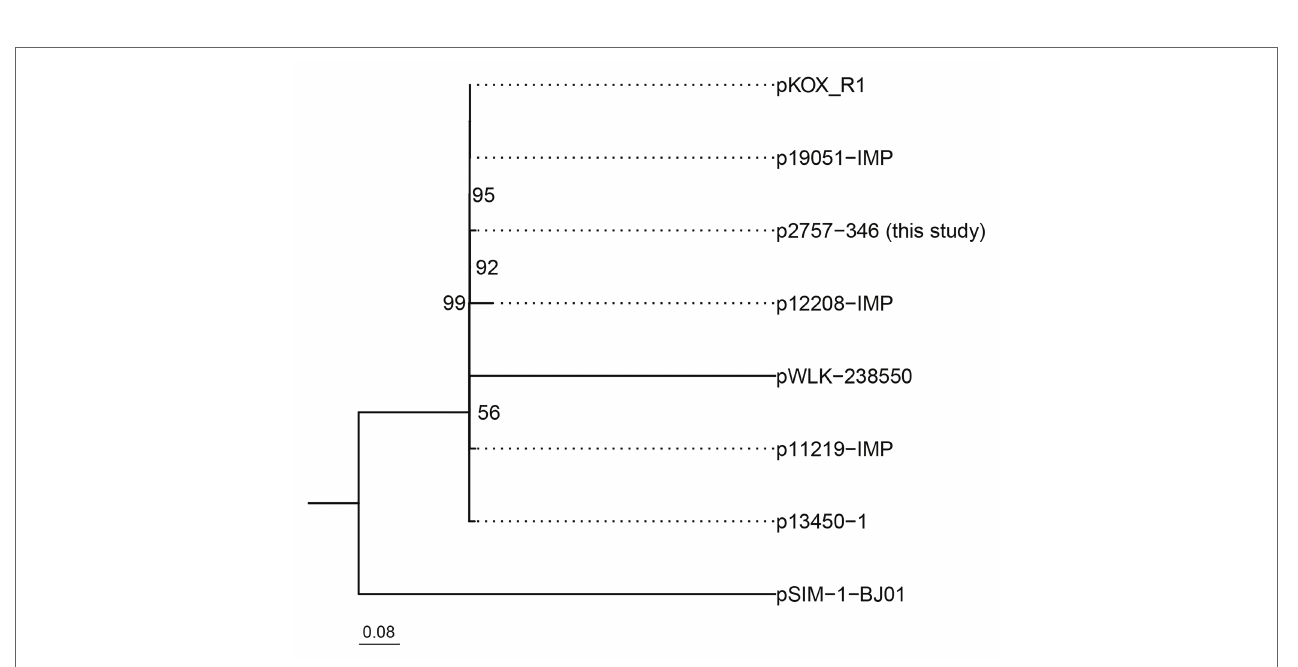
FIGURE 3 | Phylogenetic tree of eight IncH5 plasmids. The bootstrap values are given at the nodes of the tree; values <50% are not shown. The bar corresponds to the scale of sequence